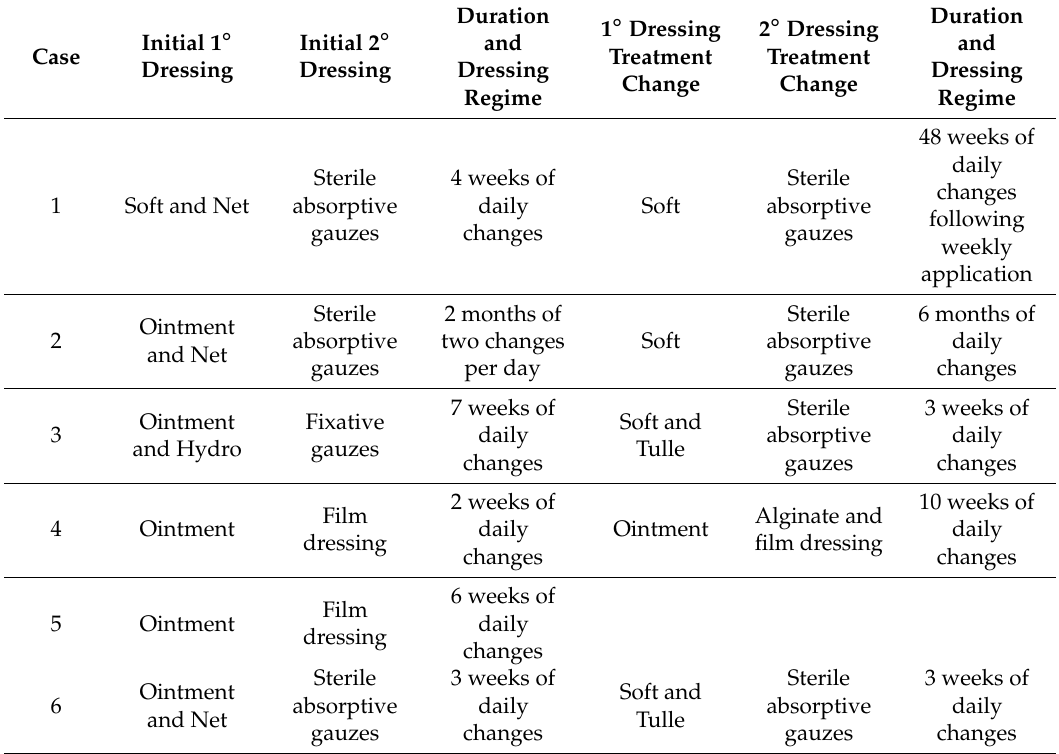
Table 2. Wound management overview of each case and their respective L-Mesitran products. Ointment, a 48% MGH lanolin ointment; Soft, a 40% MGH wound gel; Net, a hydrocolloid net dressing containing 20% MGH; Hydro, a hydrogel containing 30%